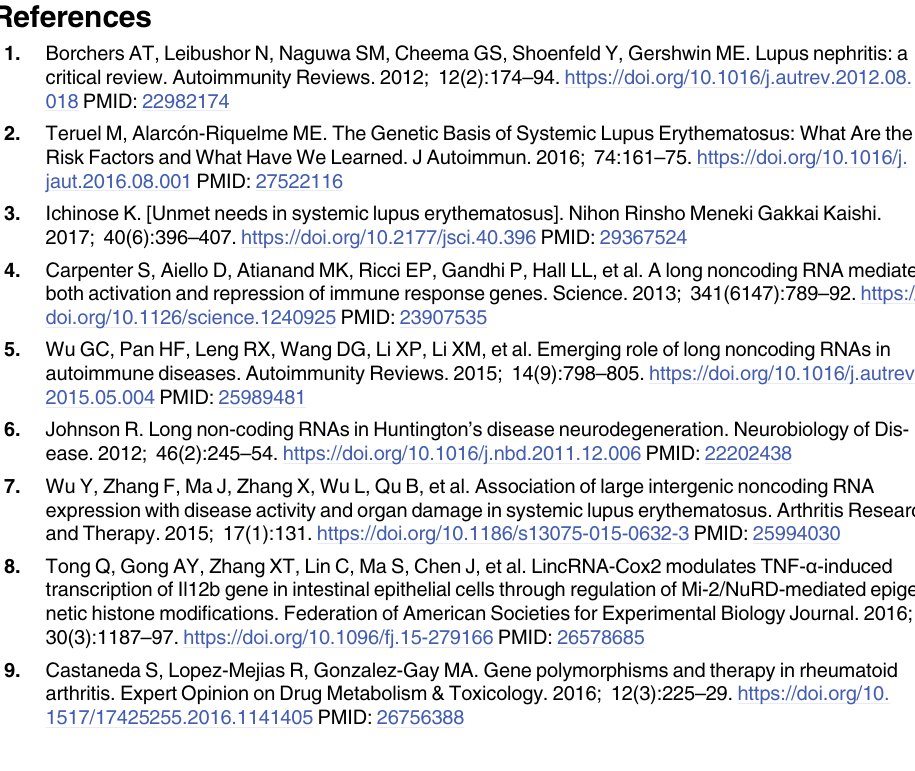
S2 Table. Validity of lnc-Cox2 and HOTAIR for differentiation between systemic lupus erythematosus patients and healthy